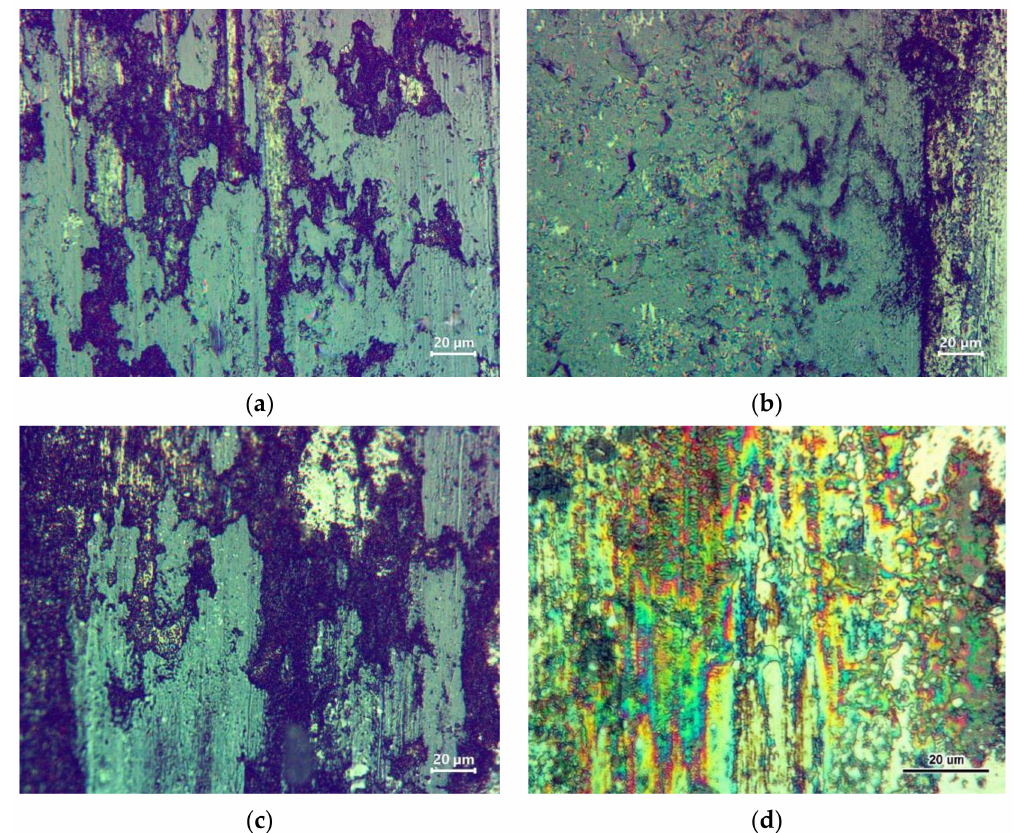
Figure 15. Oxide films on the worn surface of the specimens: ( a ) 100Cr6-substrate (steel of AISI 4145H grade), ( b ) SiC-substrate (steel of AISI 4145H grade), ( c ) 100Cr6-coating, ( d )